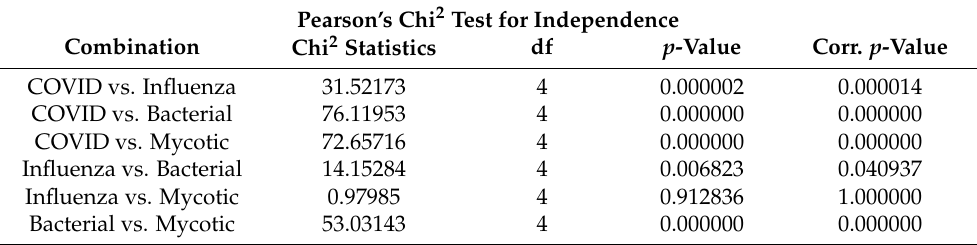
Table 3. Dependencies of radiologist’s suspicion scores for different pathogen categories were screened by Pearson’s Chi 2 Test for Independence (statistics including corrections for multiple testing using the Bonferroni